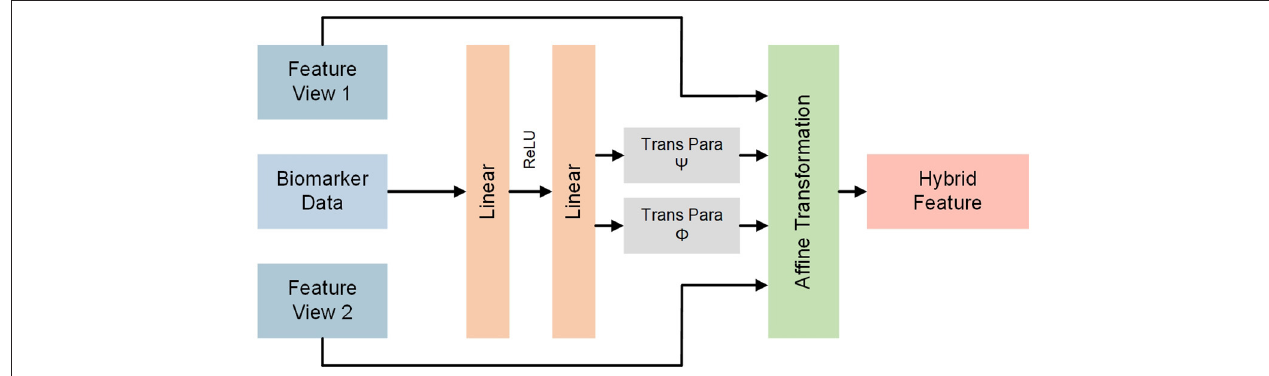
FIGURE 4 | Detailed architectures of biomedical transform module. The biomedical transform module receives biomedical indices and generates parameters of affine transformation for ultrasonic features to obtain hybrid features.